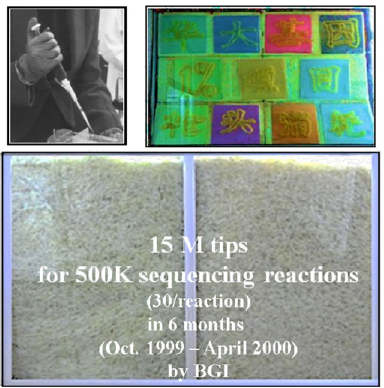
Figure 2. A lab for the “ 1% Project ” . Figure 3. A small sampling of used tips for the “ 1%